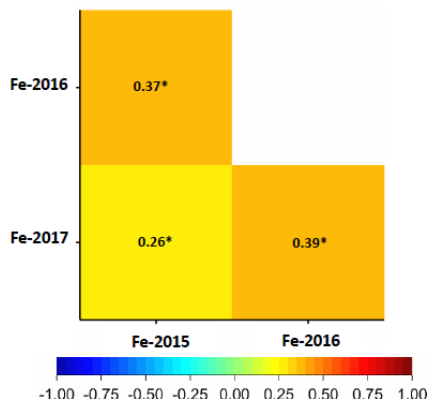
Figure 2. Pearson correlation between Fe grain concentrations (μg g −1 ) in the years 2015, 2016 and 2017. The degree of significance indicated as * p ≤ 0.05.